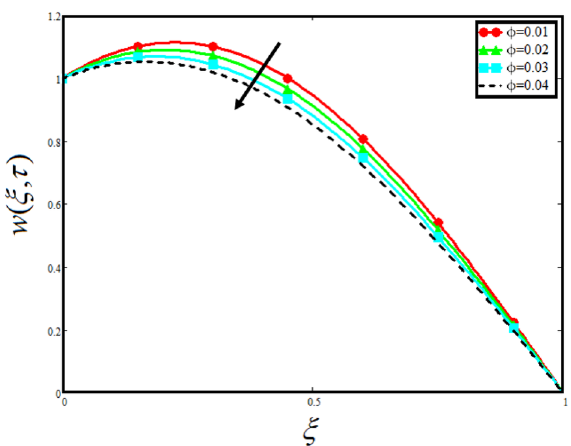
Figure 9. Variation in velocity of nanofluid against different values of φ hnf when τ = 1 , α = 0.5 , Pr = 21 , Gr = 4 , G = 2 , (cid:31) = 3 , β = 1.2 and Re = 1.2 .